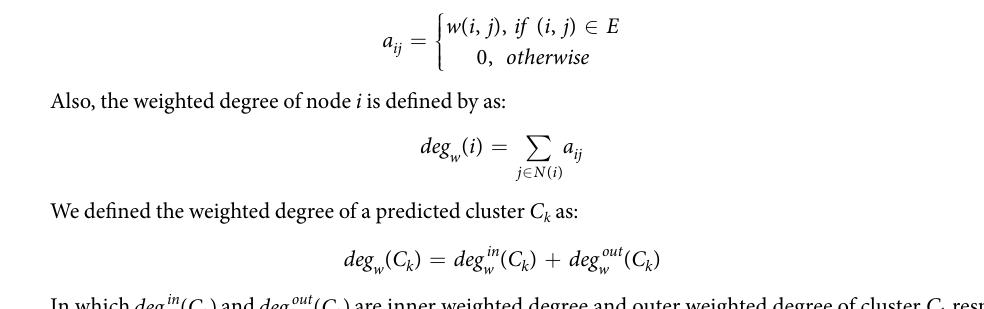
Old performance